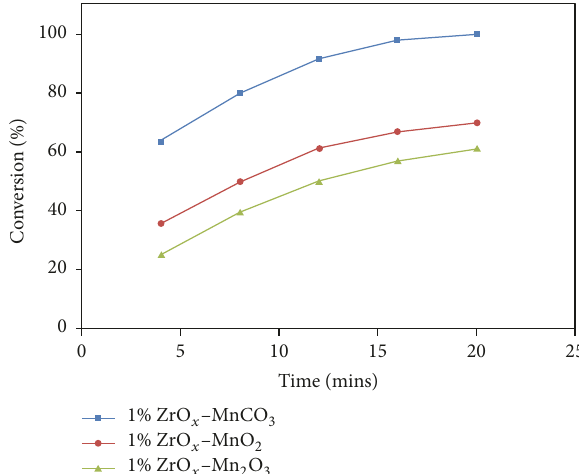
Figure 6: Graphical representation of 1-phenylethanol oxidation using catalyst calcined at different calcination